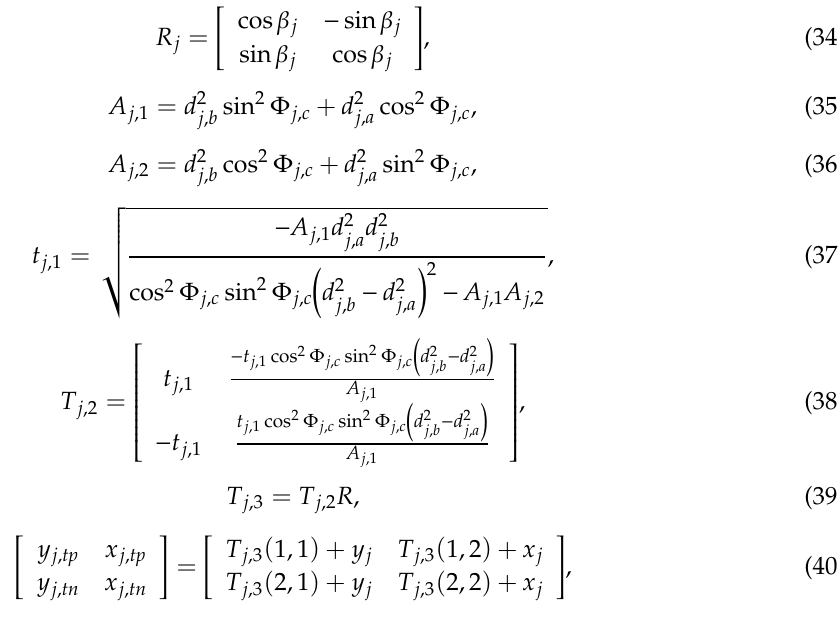
Table 1. HPL for various heading errors estimations. s ψ [º] HPL [m]